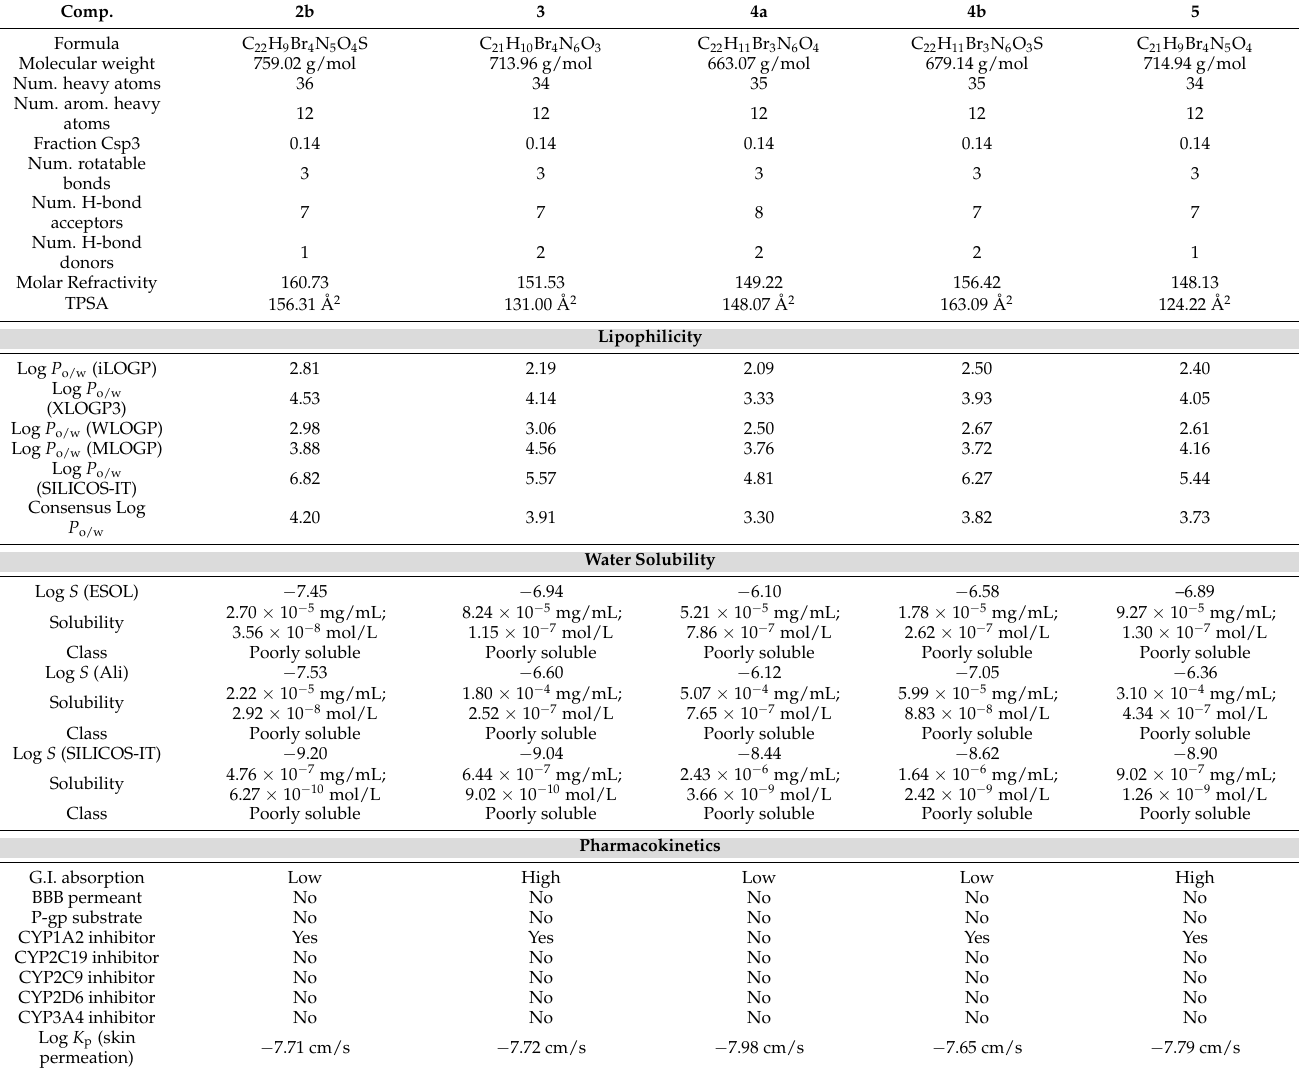
Table 9. Physicochemical